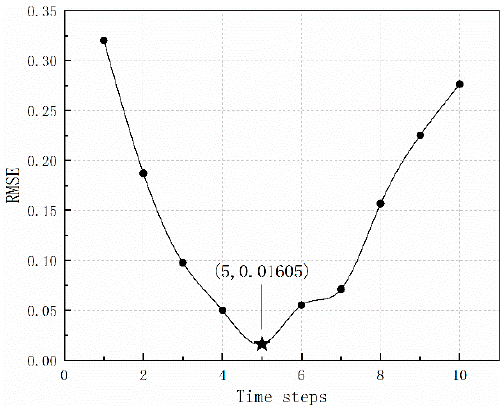
Figure 6. RMSE with different time steps. Figure 6. Root Mean Squared Error (RMSE) with di ff erent time steps.